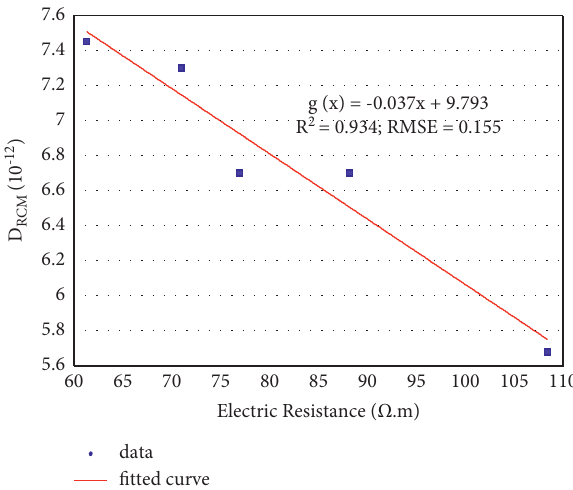
Figure 20: Chloride diffusion coefficient-electric resistance relationship.